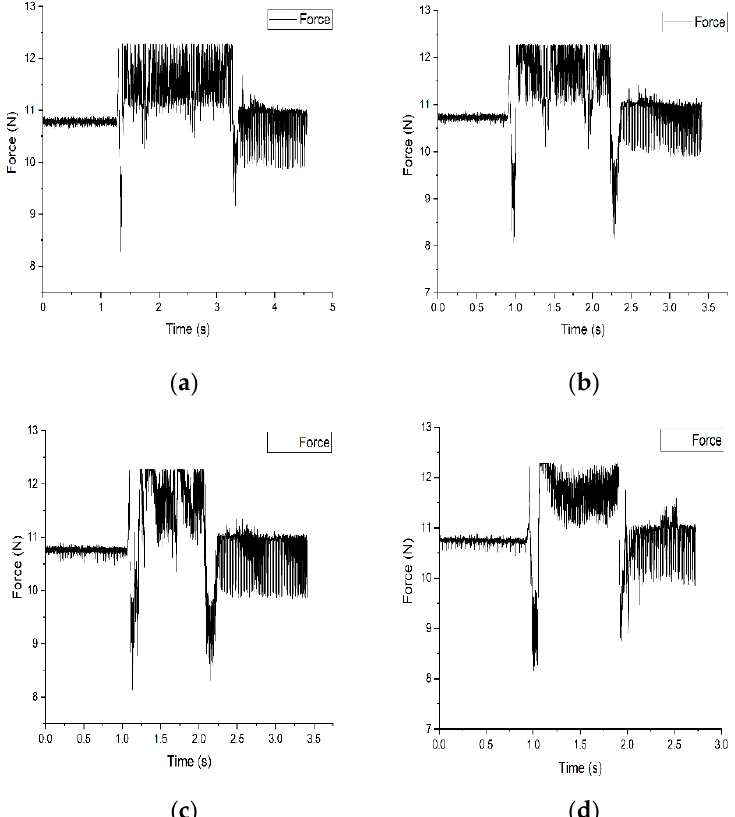
Figure 7. Effect of different speeds on the force of the grape cluster during vertical transportation test: ( a ) 0.4 m/s; ( b ) 0.6 m/s; ( c ) 0.8 m/s; ( d ) 1.0 m/s.